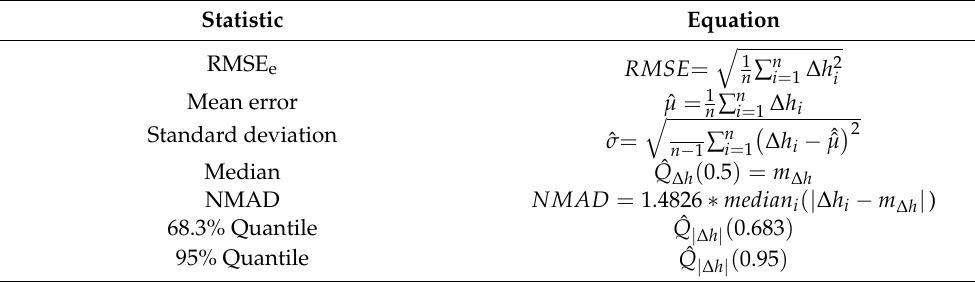
Table 3. Traditional and robust statistical metrics for errors. N is the total number of independent observations. ∆ h i denotes the individual elevation differences between strategies or errors and I = 1, . . . ,n are independent observations. ˆ σ stands for standard deviation. RMSEe stands for root mean squared error, n denotes the number of data points, ˆ µ denotes mean, m ∆ h denotes median, and NMAD denotes normalized median absolute